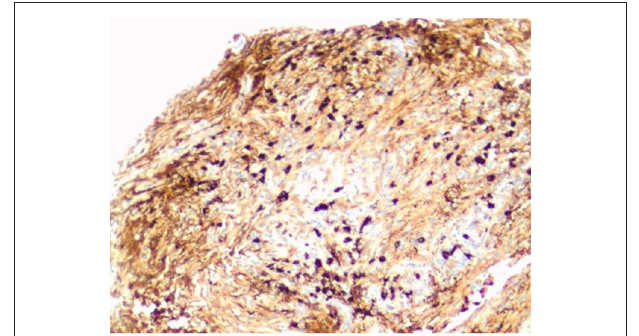
FIGURE 4 | IgG4 immunohistochemical stain highlights the IgG4-positive plasma cells. There are more than 50 IgG4-positive cells in this field (magnification ×